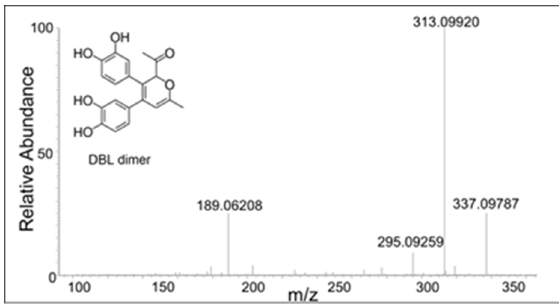
Figure 7. The CID mass spectrum of the m/z 355 mass unit ion eluting at 21 min. Its possible structure is indicated.